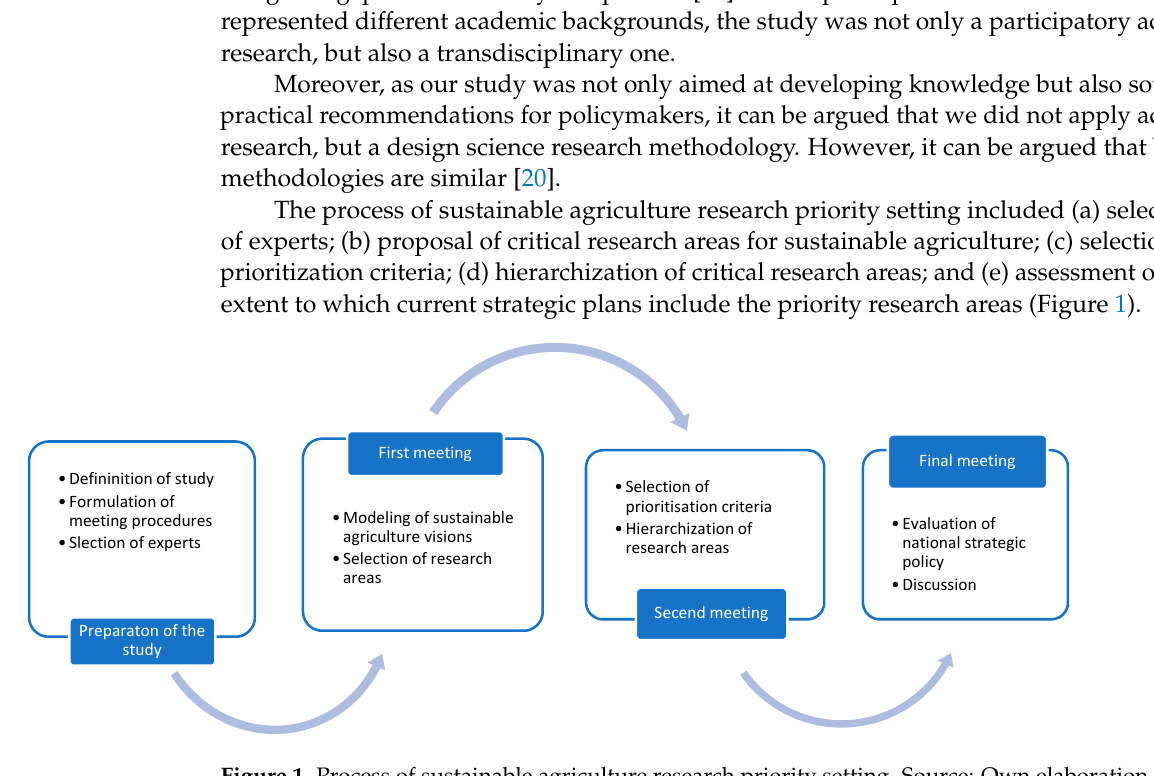
Figure 1. Process of sustainable agriculture research priority setting. Source: Own elaboration.